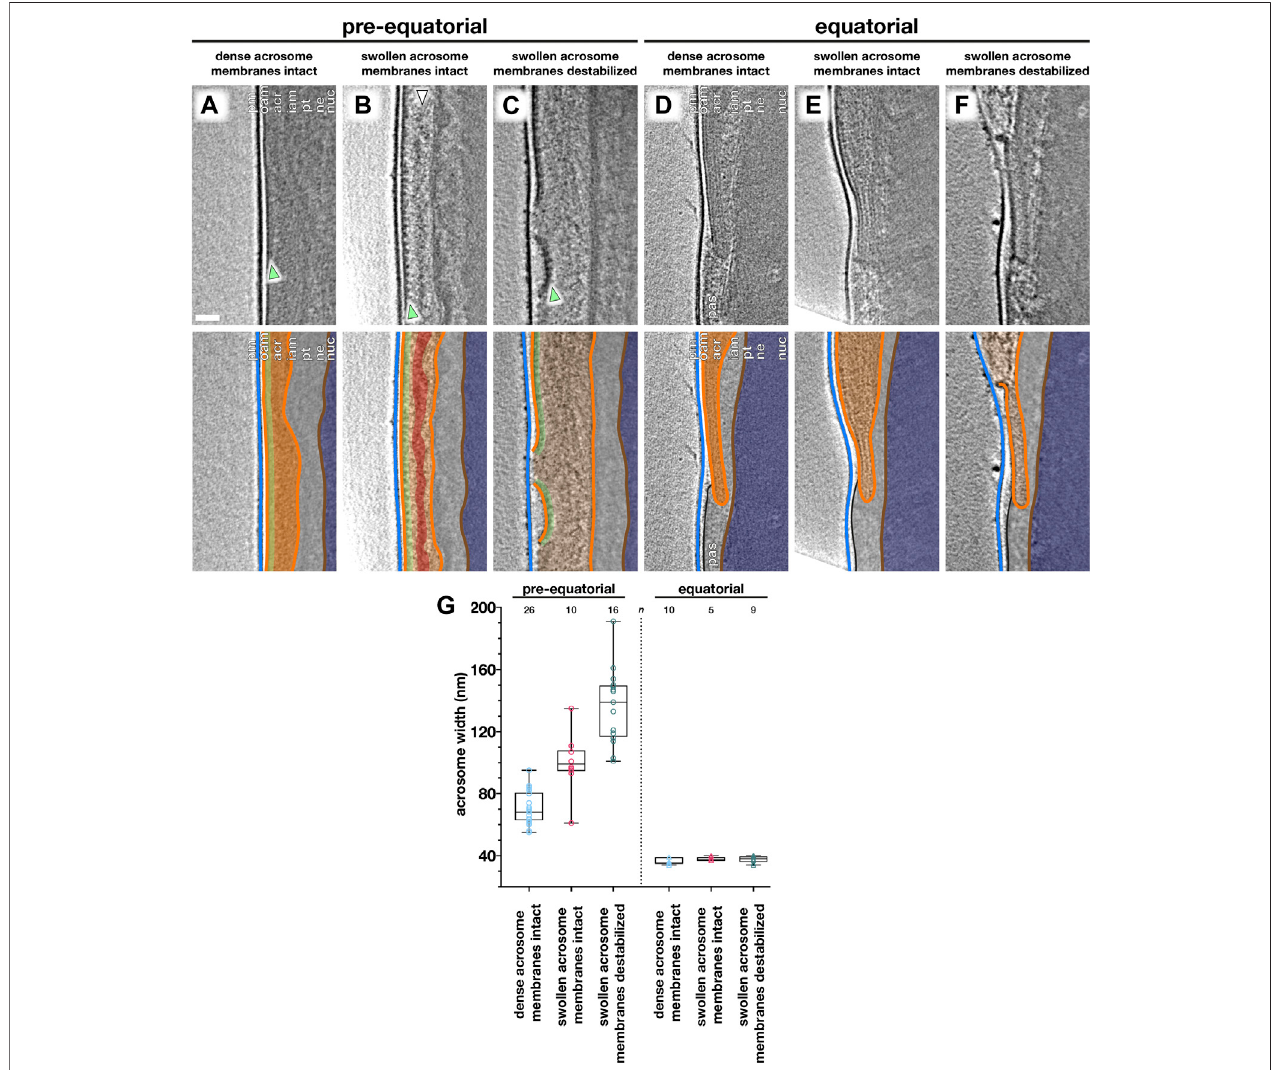
FIGURE 3 | Acrosome swelling is associated with membrane destabilization in capacitated sperm. (A – F) Computational slices (top panels) and schematic annotations(bottompanels)ofVoltaphaseplatecryotomogramsofthepre-equatorial (A – C) andequatorial (D – F) regionofspermbefore (A,D) orafter(B – C,E – F)a ∼ 2-h incubation in capacitating media without ionophore stimulation. Note the rows of membrane protein densities on the outer acrosomal membrane (green arrowheads in A – C) and the streak of acrosomal matrix that remains condensed during acrosome swelling (white arrowhead in B ). (G) Measurements of acrosomal width at the pre-equatorial (left) and equatorial (right) regions in sperm showing various states of acrosome swelling and membrane destabilization. For each tomogram, acrosome width was measured as the distance between the outer and inner acrosomal membranes at three different locations. Every data point represents the average of these three measurements for the relevant tomogram. Each tomogram is from a different cell ( n indicates the number of tomograms used for analysis). The boxes indicate the medianandinterquartilerange,whilethewhiskersindicatetheminimumandmaximumvalues.Scalebar:50 nm.Labels:pm,plasmamembrane;oam,outeracrosomal membrane; acr, acrosome; iam, inner acrosomal membrane; pt, perinuclear theca; ne, nuclear envelope; nuc, nucleus; pas, post-acrosomal sheath. Color scheme: blue — plasma membrane, orange — outer and inner acrosomal membranes, green — membrane protein densities, red — condensed acrosomal material, light gray — perinuclear theca and post-acrosomal sheath, brown — nuclear envelope, dark blue — nucleus.